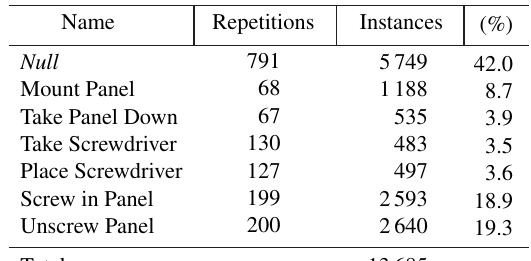
Table 2. Class labels and their distributions for the Overhead Car Assembly (OCA) dataset. Repetitions and instances show the distribution of the individual classes (across all subjects and sessions) after application of the sliding window